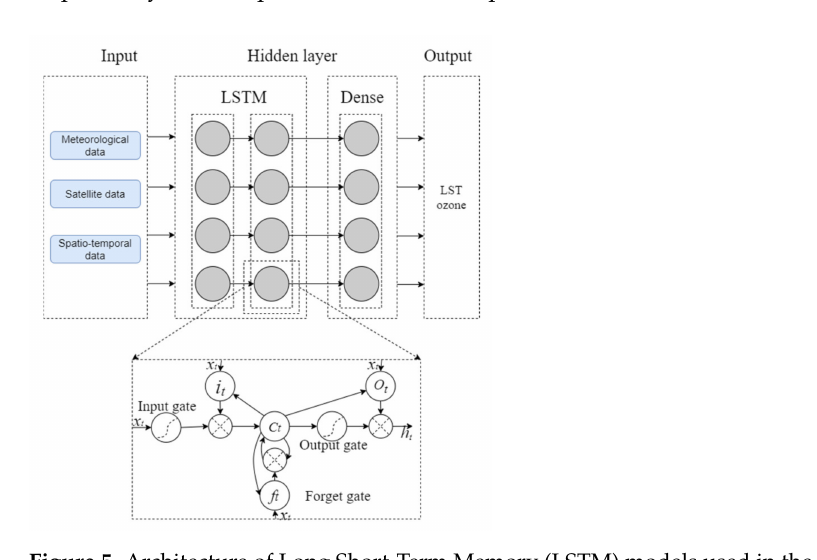
Figure 5. Architecture of Long Short-Term Memory (LSTM) models used in the